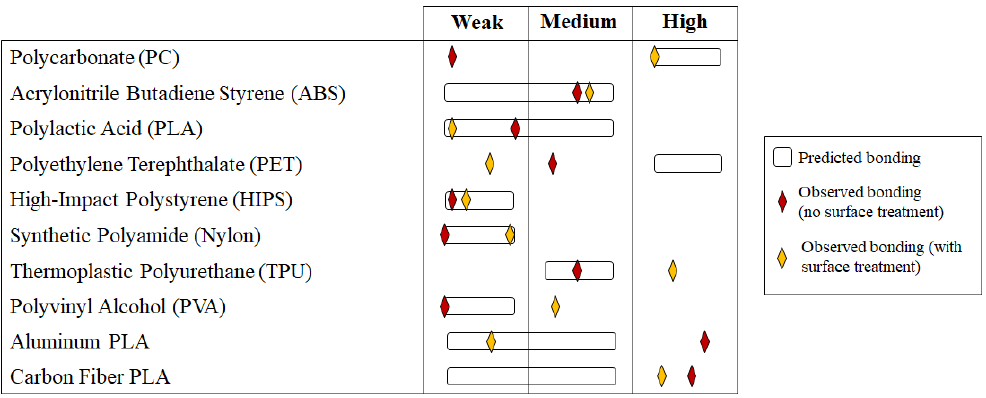
Figure 19. Printed samples of the studied materials, ( a ) ABS, ( b ) PLA, ( c ) PET, ( d ) HIPS, ( e ) PC, ( f ) TPU, ( g ) PVA, ( h ) nylon, ( i ) aluminum PLA, and ( j ) carbon fiber PLA. Table 4. Printing test results for untreated PC build plate.